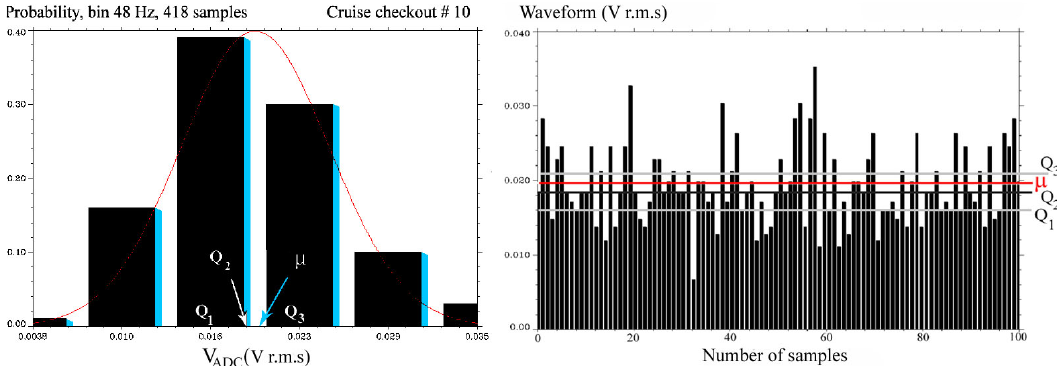
Fig. 2. Amplitude distribution (left) and waveform (right) of the first hundred V ADC samples of bin 48 of the Cruise checkout # 10. The bar levels represent the fractional amount of samples distributed among 6 classes about 6.26 mV RMS wide each, distributed between the min and max values of the series. The solid red line is the theoretical shape of a normal distribution with expectation equal to µ .